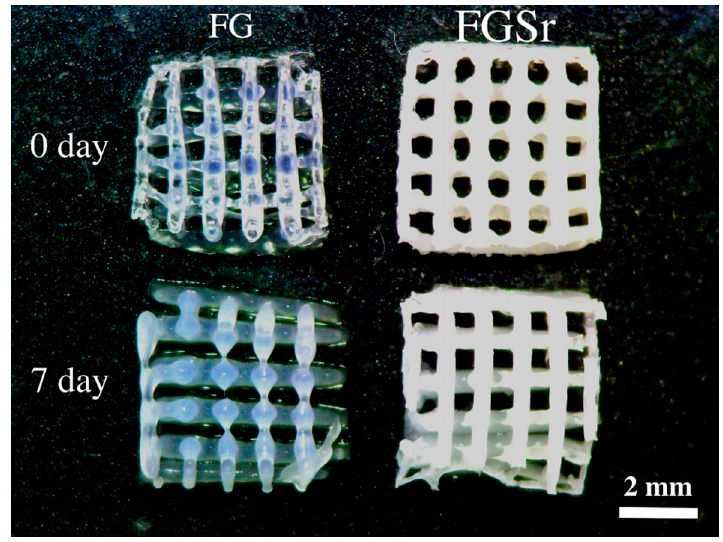
Figure 1. The top-view photograph of 3D-printed scaffolds before and after immersed in SBF.